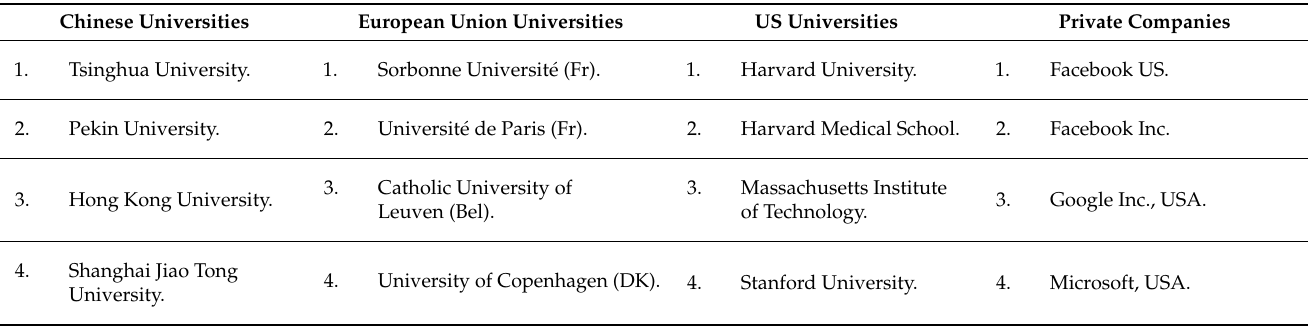
Table A1. Chinese, European Union, and United States universities and private companies occupying the top 30 spots in the SCimago